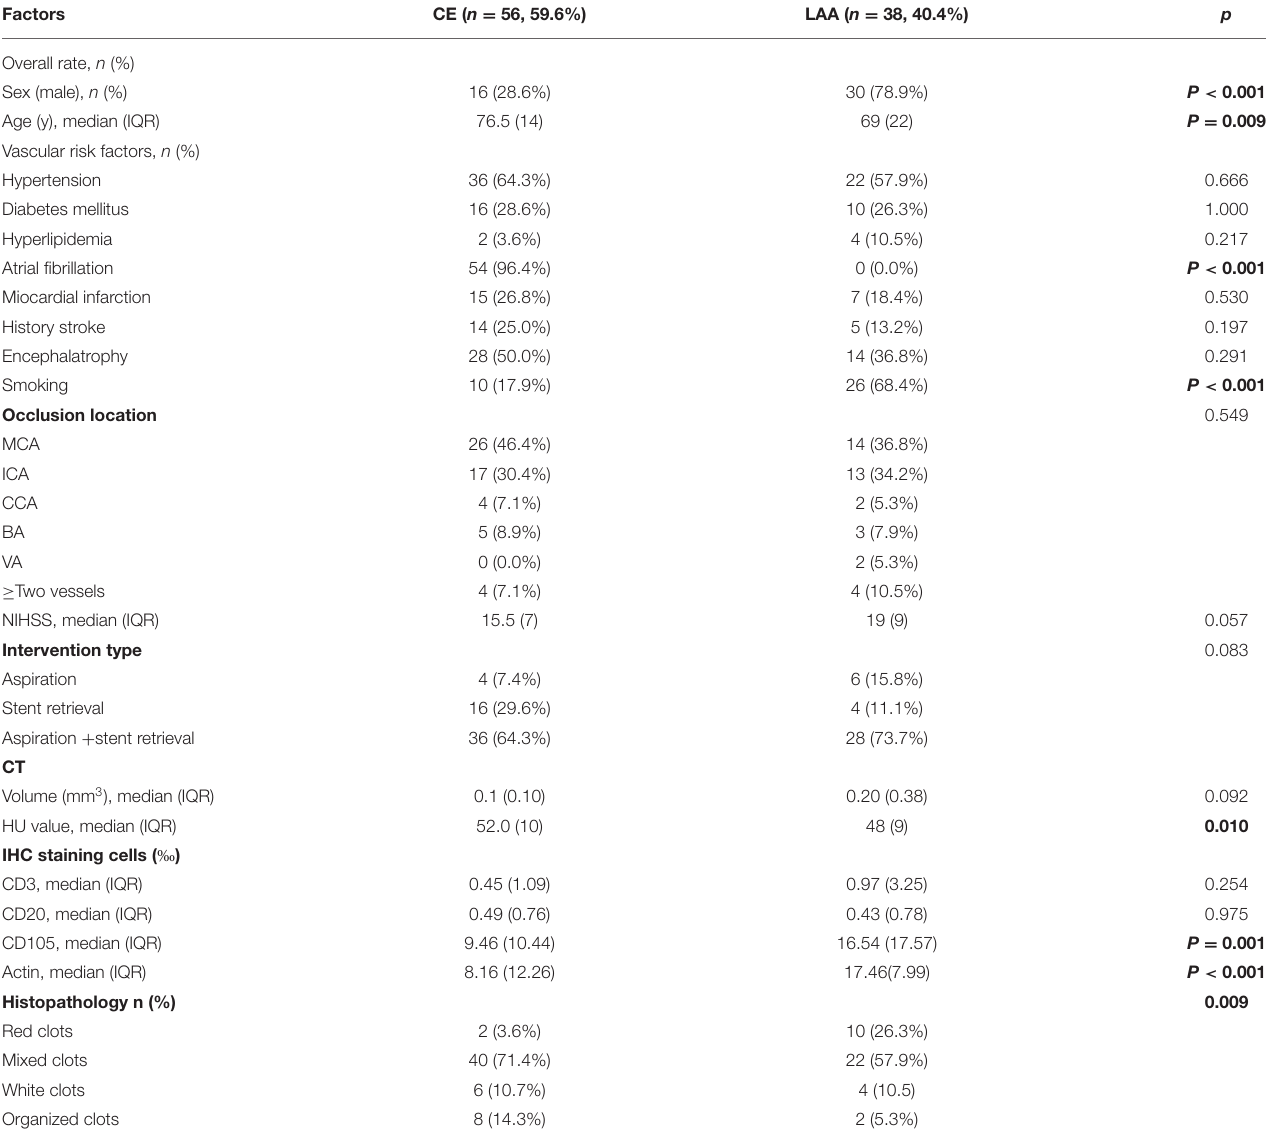
TABLE 1 | Demographic and clinical characteristics of the patients. Factors